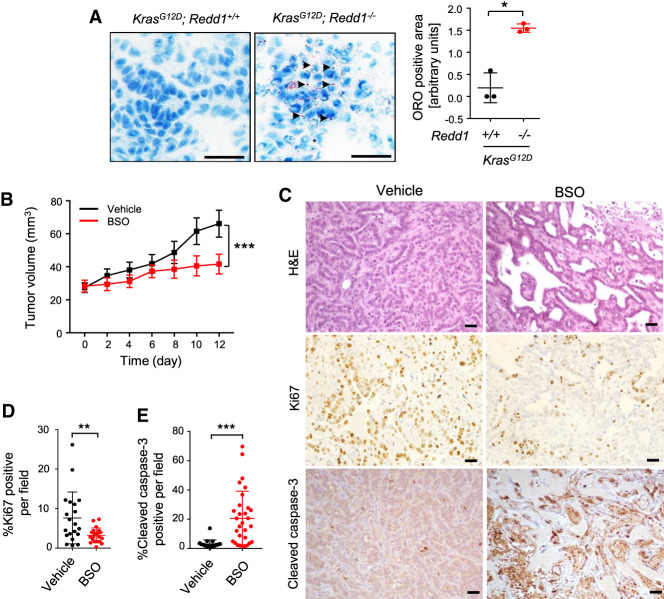
REDD1-deficient tumors show increased lipid storage and glutathione dependence. (A) Accumulation of neutral lipid droplets analyzed by Oil Red O (ORO) staining of matched AdK and AdKR primary lung tumor sections, showing characteristic speckled droplets only in AdKR tumors. Scale bars, 20 µm. (Right) Summary quantification of ORO staining in lung and pancreatic tumors of the indicated genotypes. Values represent mean ± SEM. (*) P = 0.030, by paired t-test. (B) AdKR orthotopic tumors are responsive to glutathione synthase inhibitor buthionine sulfoximine (BSO). Cells from tumors shown in Figure 1E were implanted subcutaneously, and BSO (10 mmol/kg, daily) was administered by i.p. injection 14 d after implantation (=day 0). (***) P < 0.001 by one-way ANOVA. (C) Representative sections of AdKR orthotopic tumors stained by H&E (top), Ki67 (middle), and cleaved caspase-3 (bottom) after 12-d treatment with vehicle or BSO. Scale bars, 20 µm. (D) Quantification of Ki67-positive cell percentage from AdKR orthotopic mouse tumor sections from C. (E) Quantification of cleaved caspase-3 positive cells from AdKR orthotopic mouse tumor sections from C. For D and E, five random fields per tumor from each of five randomly selected tumors were quantitated. Data represent mean ± SD. (*) P < 0.05; (**) P < 0.01; (***) P < 0.001, by two-tailed t-test. See also Supplemental Figure S4.